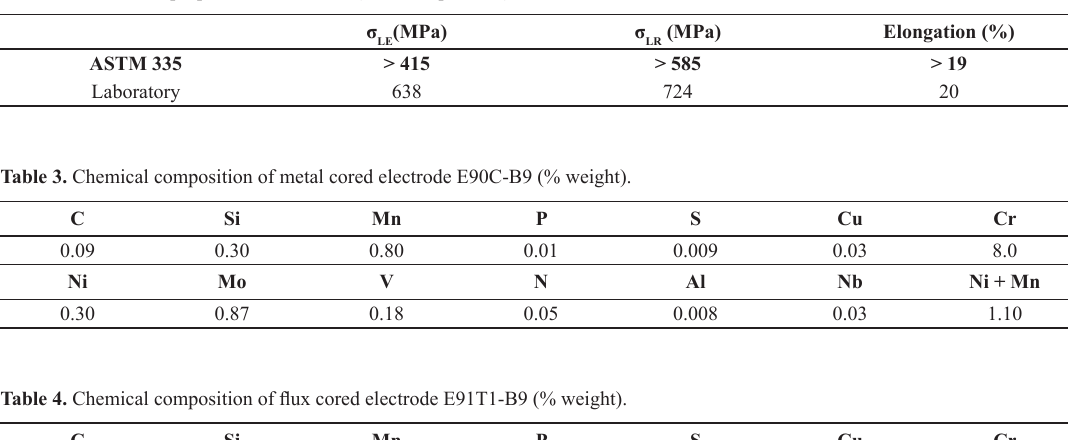
Table 2. Mechanical properties of P91 steel (room temperature).